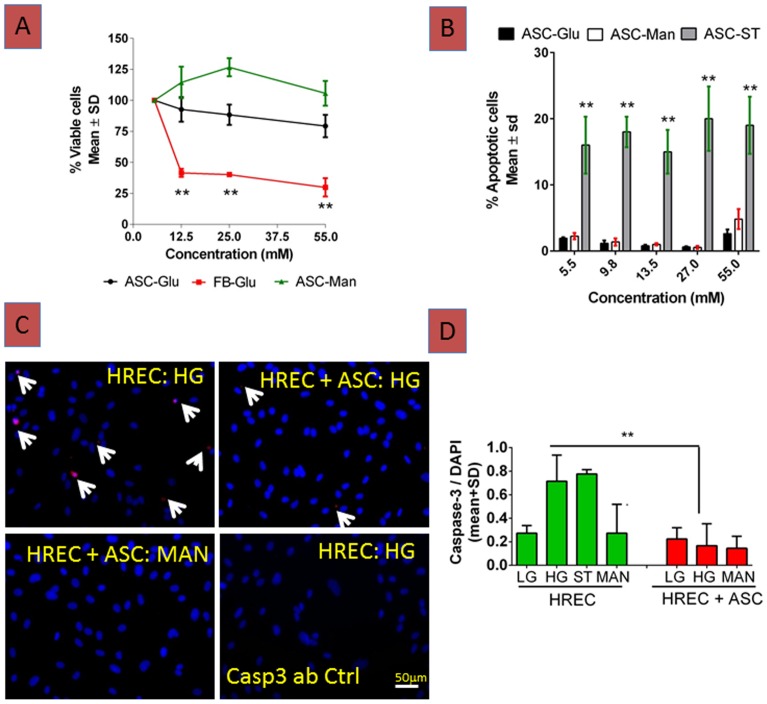

In vitro ASC withstand hyperglycemic stress with minimal apoptosis and increase retinal endothelial survival.(A). Number of viable cells at normal (5.5 mM) or high glucose concentrations did not change at 72hrs as evidenced from the quantity of formazan product measured at 490 nm, is directly proportional to the number of living cells in culture. On the other hand, normal human fibroblasts (HDF) demonstrated a significant decrease (**p<0.01) in viable cells in comparison to ASC. Mannitol (Man) used as osmolality control did not affect ASC. (B). ASC treated with increasing doses of glucose or mannitol were fixed in Prefer fixative. Cells in each well were stained using an active caspase-3 antibody (Promega Corp). The % apoptotic cells were calculated based on total fluorescence intensity of caspase-3 stained cells relative to total cell count. As expected staurosporine (ST, 1 µM) caused massive cell death (**p<0.01) at low glucose (5.5 mM), whereas both high glucose and mannitol did not show any significant (p>0.05) apoptosis compared to low glucose. (C). HREC co-cultured with ASC and exposed to high glucose (HG; 25 mM) were protected from apoptosis as shown by decrease in active caspase-3 staining in co-cultures compared to HREC cultured alone with HG (arrows). (D). Quantification of total fluorescence intensity of caspase-3 stained cells relative to total cell count by MetaMorph show a significant decrease in caspase-3 staining, **p<0.01. Mannitol (MAN) at 25 mM served as an osmolality control and had no effect.